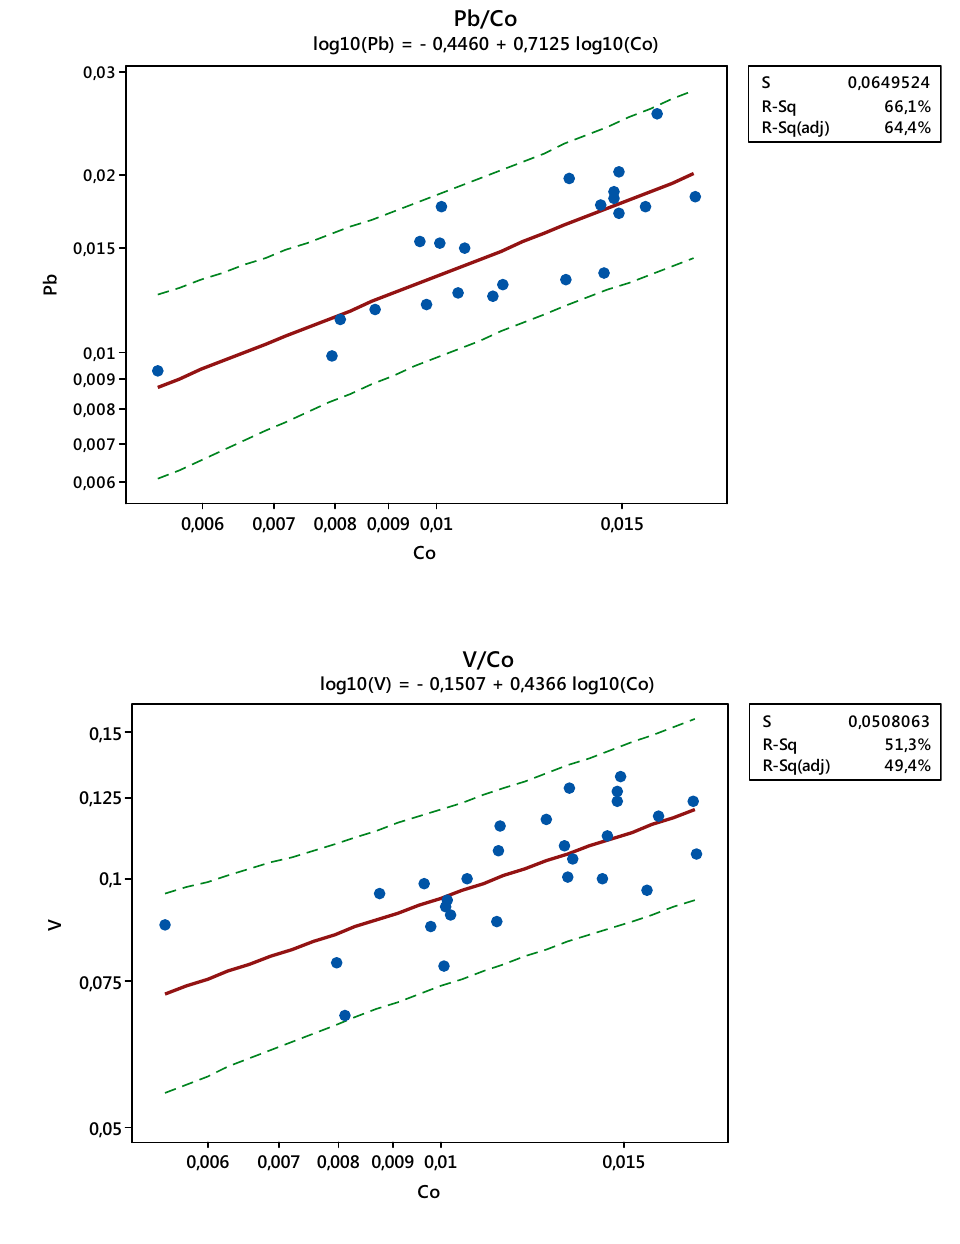
Fig. 4 Linear regression graph of lead background concentra- tion determination ( R 2 = 66.1%)